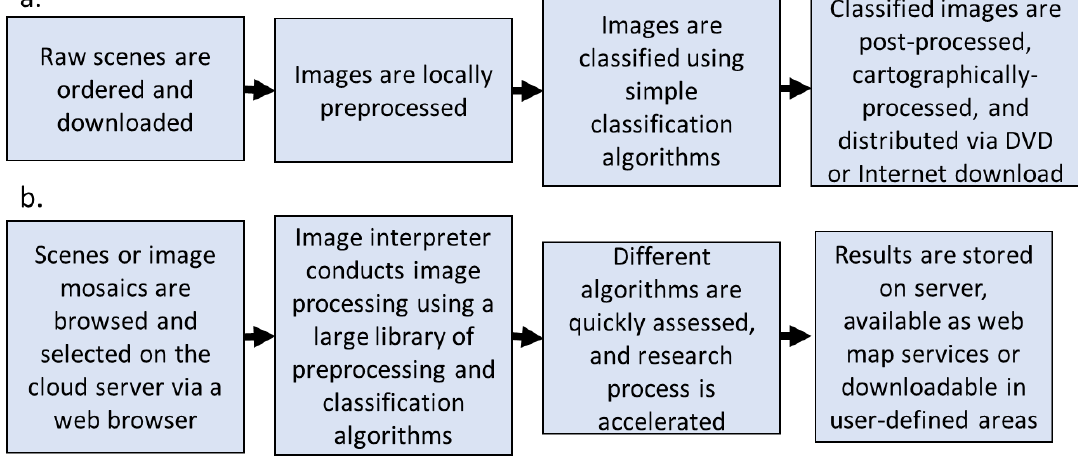
Figure 2. Description of two processes for conducting remote sensing. ( a ) Traditional approach, prior to era of cloud computing; ( b ) Workflow that is used during the era of cloud computing.